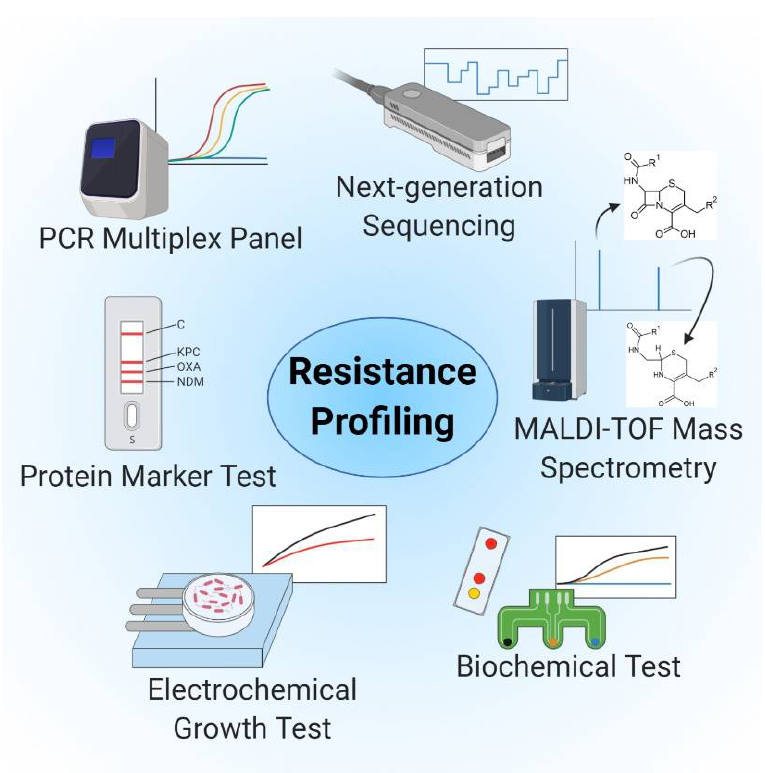
Figure 4. Overview of current and promising technologies suitable for antimicrobial resistance profiling. Beside classical culture-based approaches (not included), currently available commercial solutions include PCR multiplex panels (e.g., Biofire ®- FilmArray® panels (biomérieux)), MALDI-TOF MS (MTB-STAR Assays (Bruker Daltonics, Inc.)), biochemical tests (e.g., RAPIDEC® CARBA NP test (biomérieux)) and protein marker tests (e.g., RESIST-3 O.K.N. K -SeT (Coris BioConcept, Gembloux, Belgium)). Further promising technological advances have been made in the field of Next-generation Sequencing (e.g., [174]) adaption of biochemical tests to faster electrochemical formats (e.g., [167]) or development of electrochemical sensors for bacterial growth (e.g., [154]). Several of these approaches are suspected to result in commercially available solutions for antimicrobial resistance profiling in the future.